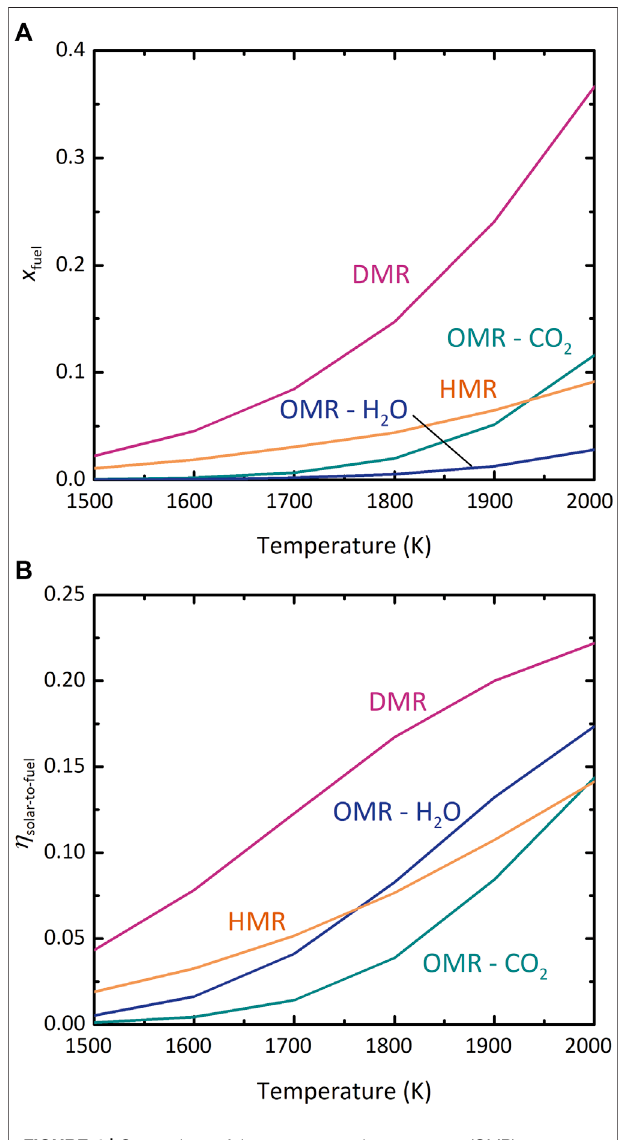
FIGURE 4 | Comparison of the oxygen-membrane reactor (OMR), hydrogen-membrane reactor (HMR), and dual-membrane reactor (DMR) con fi gurations. (A) x fuel vs. T , (B) η solar-to-fuel vs. T . p I , p II (cid:2) 1 bar, where applicable. p